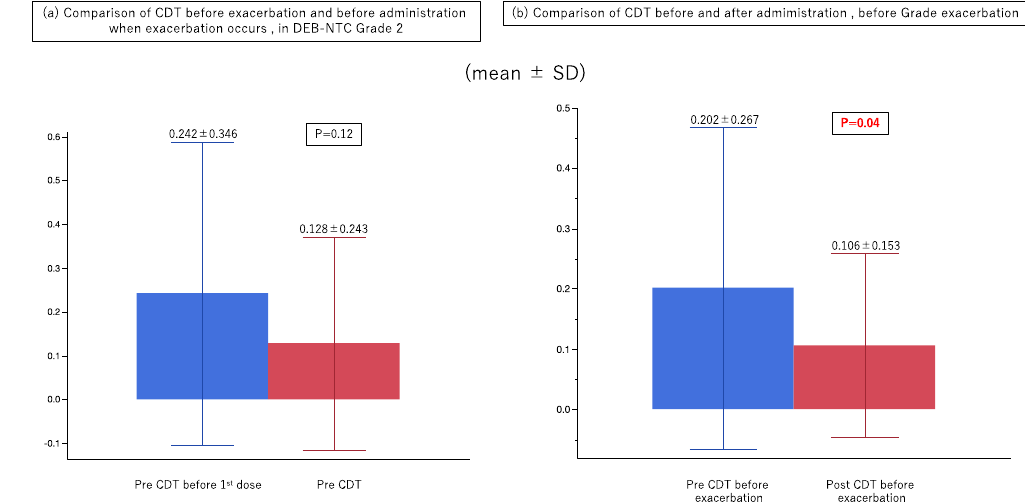
Figure 5 (a) Comparison of the pre-administration cold sensation detection threshold (CDT) before exacerbation and when exacerbation occurred in cases with Neurotoxicity Criteria of Debiopharm (DEB-NTC) grade 2. The CDT tended to be lower when exacerbation occurred, but this change was not significant ( P =0.12). (b) Comparison of CDT before and after administration, before grade exacerbation. The CDT was significantly reduced in all grade-exacerbated cases, not only in grade 2 (